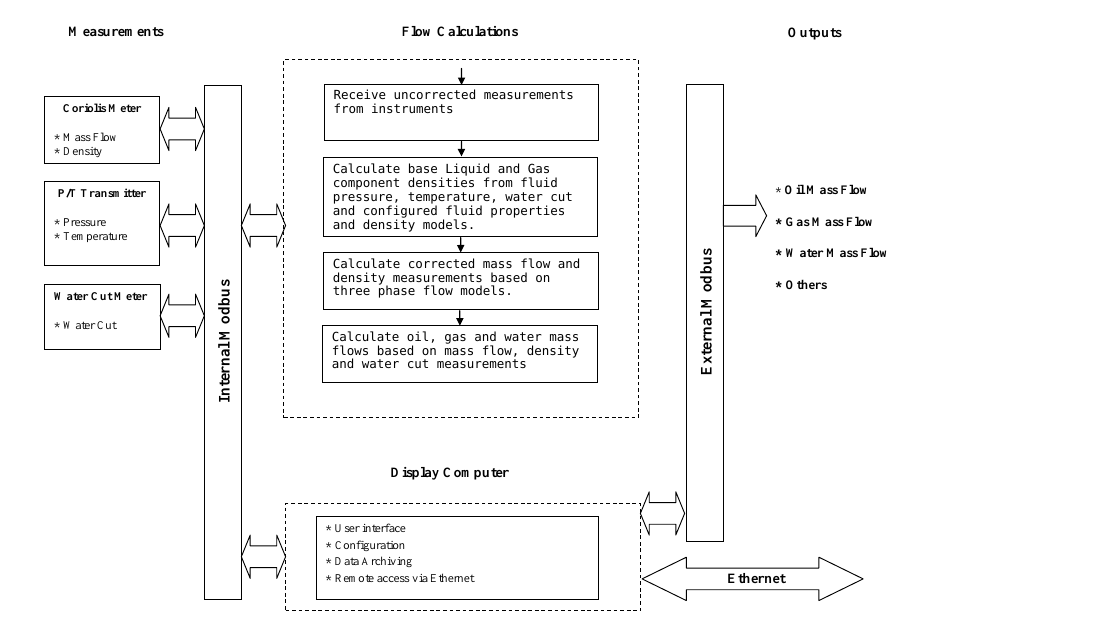
Figure 3. Hardware / software architecture of the Net Oil and Gas